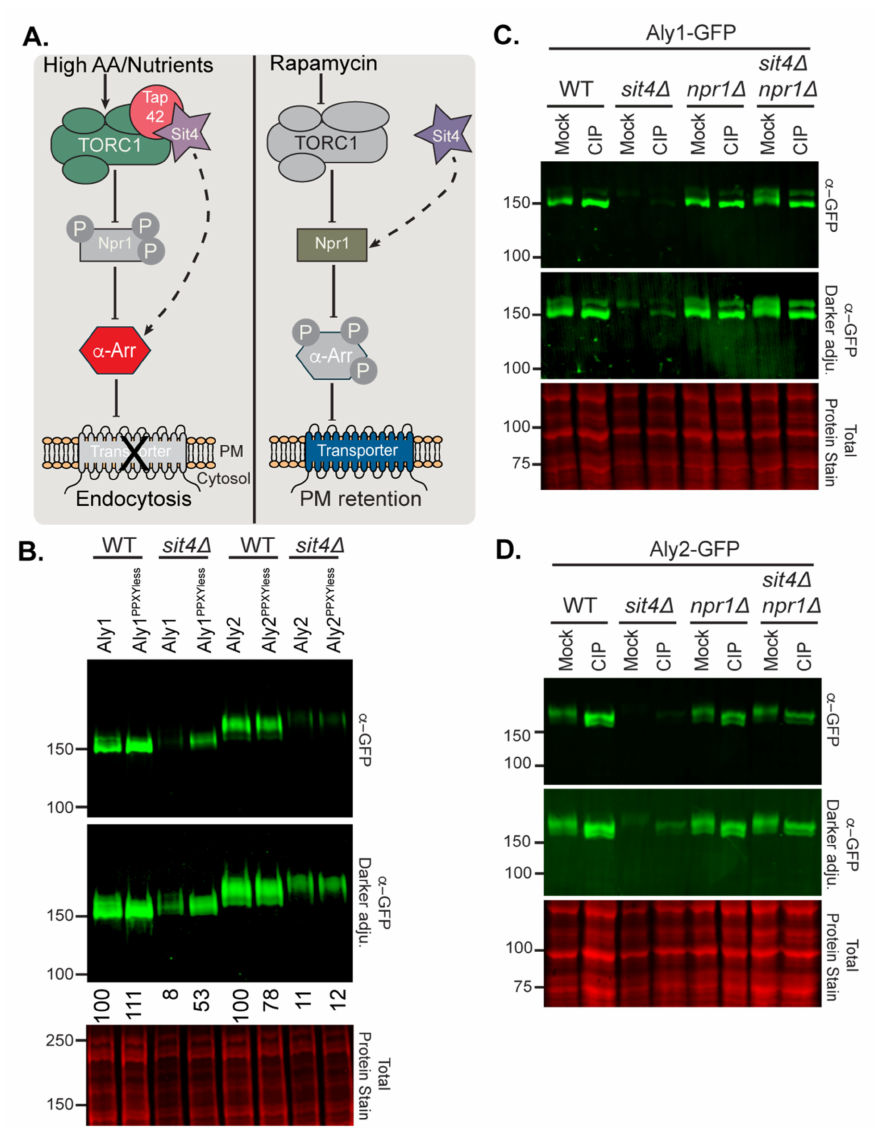
Figure 5. Sit4 and Npr1 regulate Aly abundance and phosphorylation: ( A ) Model of TORC1 regulation of Sit4 and Npr1 based on studies of Bul regulation of Gap1. In robust nutrients, TORC1 is active and Tap42-Sit4 are thought to be bound. This may direct Sit4 activity towards α -arrestins [12,13], as indicated by a dashed line. α -Arrestins are active and can remove nutrient transporters from the PM. In response to rapamycin or poor nutrient conditions, TORC1 is inhibited, and the Tap42-Sit4 complex dissociates. Sit4 phosphatase activity is now thought to be directed to Npr1 (dashed-line with arrow), which becomes active. Active Npr1 can phosphorylate and inhibit α -arrestins, preventing the removal of nutrient transporters from the PM. Activation or inhibition are indicated by lines that end in arrowheads or blunt lines, respectively. Complexes whose activity is lost in the condition indicated are shown in grey. ( B ) Whole-cell extracts were made from the indicated strains expressing Alys as GFP-tagged proteins from the TEF1pr and then resolved by SDS-PAGE. Immunoblots were probed with anti-GFP antibody to examine Aly abundance and mobility. REVERT total protein stain is shown for each blot as a loading control (red). The percent of Aly protein, corrected for the loading control, for each lane is calculated relative to WT Aly in WT cells. ( C , D ) Whole-cell extracts were made from the indicated strains expressing Aly-GFP from the TEF1pr and then were either treated with calf intestinal alkaline phosphatase (CIP) or incubated in the same conditions without enzyme (mock). Extracts were then resolved by SDS-PAGE and probed with anti-GFP antibody. REVERT total protein stain is shown for each blot as a loading control (red). For all panels, molecular weights are shown on the left side in